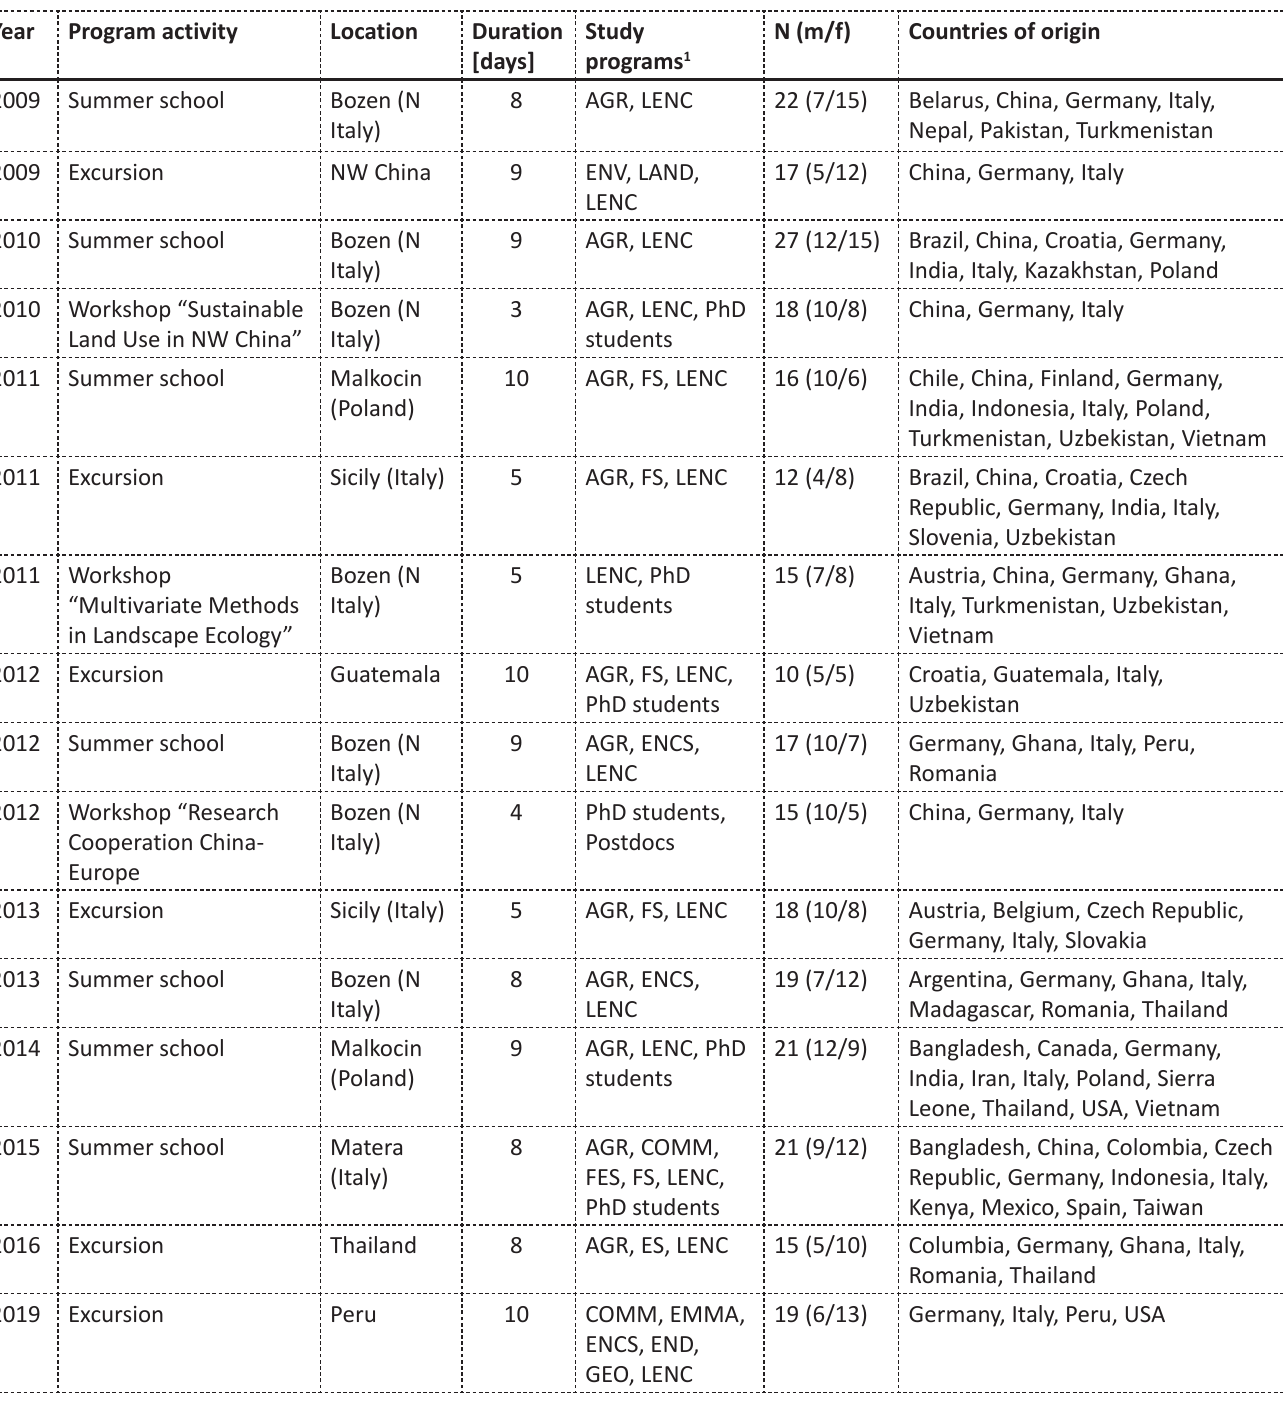
Table 2: Activities carried out within the study-abroad program hosted by the Free University of Bozen-Bolzano between 2009 and 2019, with location, duration of the activity, participating study programs, total number N of students participating (m = male, f = female students), and countries of origin of the student